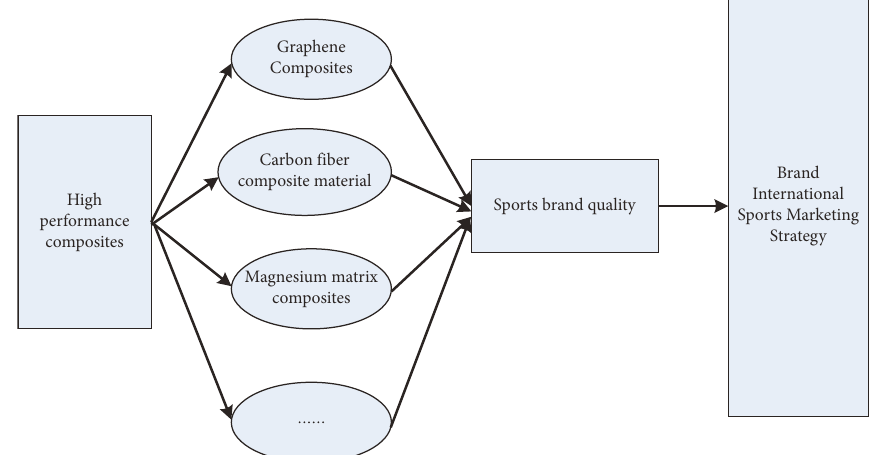
Figure 1: A structural diagram that influences a brand’s international sports marketing strategy.